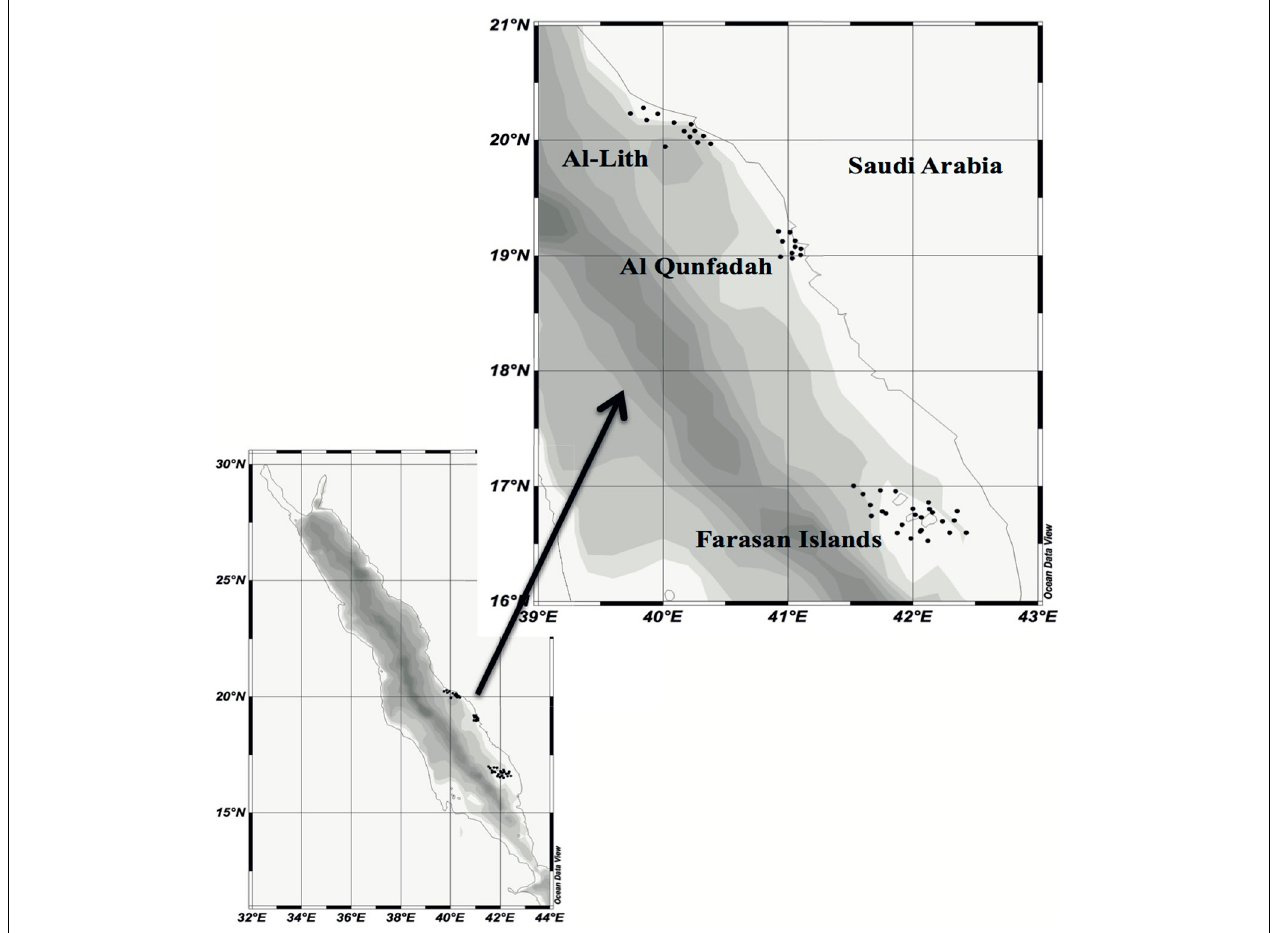
FIGURE 1 | Map illustrating the sampling points around the three different reef systems in the southern/central Red Sea. Produced with Ocean Data View (ODV) (Schlitzer, 2014).